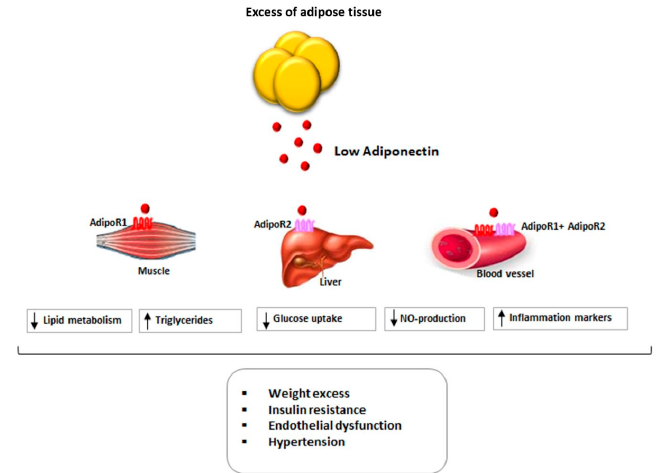
Figure 1. Relationship between Adiponectin levels and cardiovascular risk in obesity. Black arrow pointing up ( ↑ ): increase, Black arrow pointing down ( ↓ ):